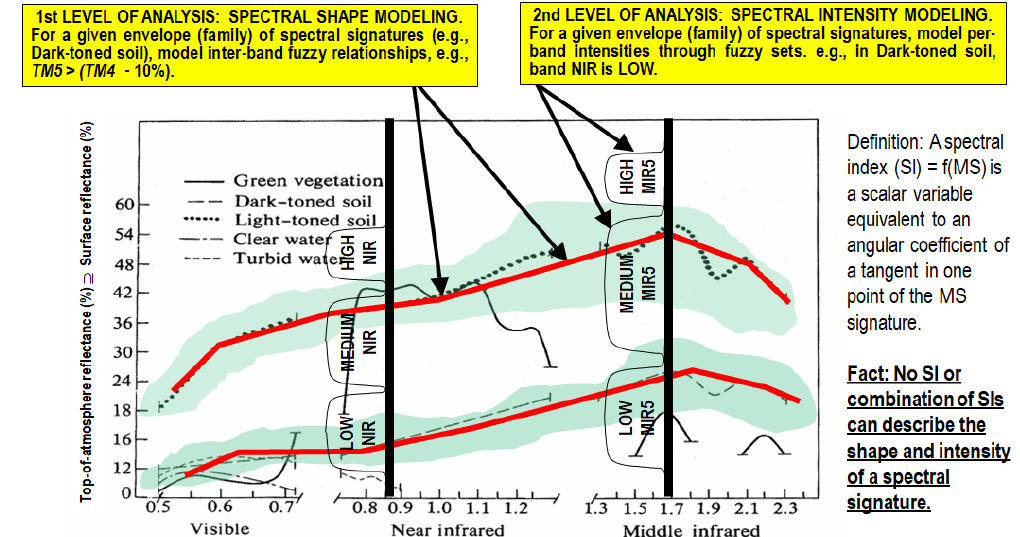
Figure 18. Examples of land cover (LC) class-specific families of spectral signatures [17] in top-of- atmosphere reflectance (TOARF) values, which include surface reflectance (SURF) values as a special case in clear sky and flat terrain conditions [173], i.e., in general, TOARF ⊇ SURF, where TOARF ≈ SURF (depicted as an ideal “noiseless” spectral signature in red) + atmospheric and topographic noise. A within-class family of spectral signatures (e.g., dark-toned soil) in TOARF or SURF values forms a buffer zone (hyperpolyhedron, envelope, manifold, joint distribution), depicted in light green. Like a vector quantity has two characteristics, a magnitude and a direction, any LC class-specific MS manifold is characterized by a multivariate shape and a multivariate intensity information component. In the RS literature, typical prior knowledge-based spectral decision trees for MS reflectance space hyperpolyhedralization into a finite and discrete vocabulary of MS color names, such as Sen2Cor’s [12], MAJA’s [46,48], ATCOR’s [71,72], LEDAPS’ [139,140,146] and LaSRC’s [139,140,160], typically adopt either a multivariate analysis of spectral indexes or a logical (AND, OR) combination of univariate variables, such as scalar spectral indexes or spectral channels, considered mutually independent.